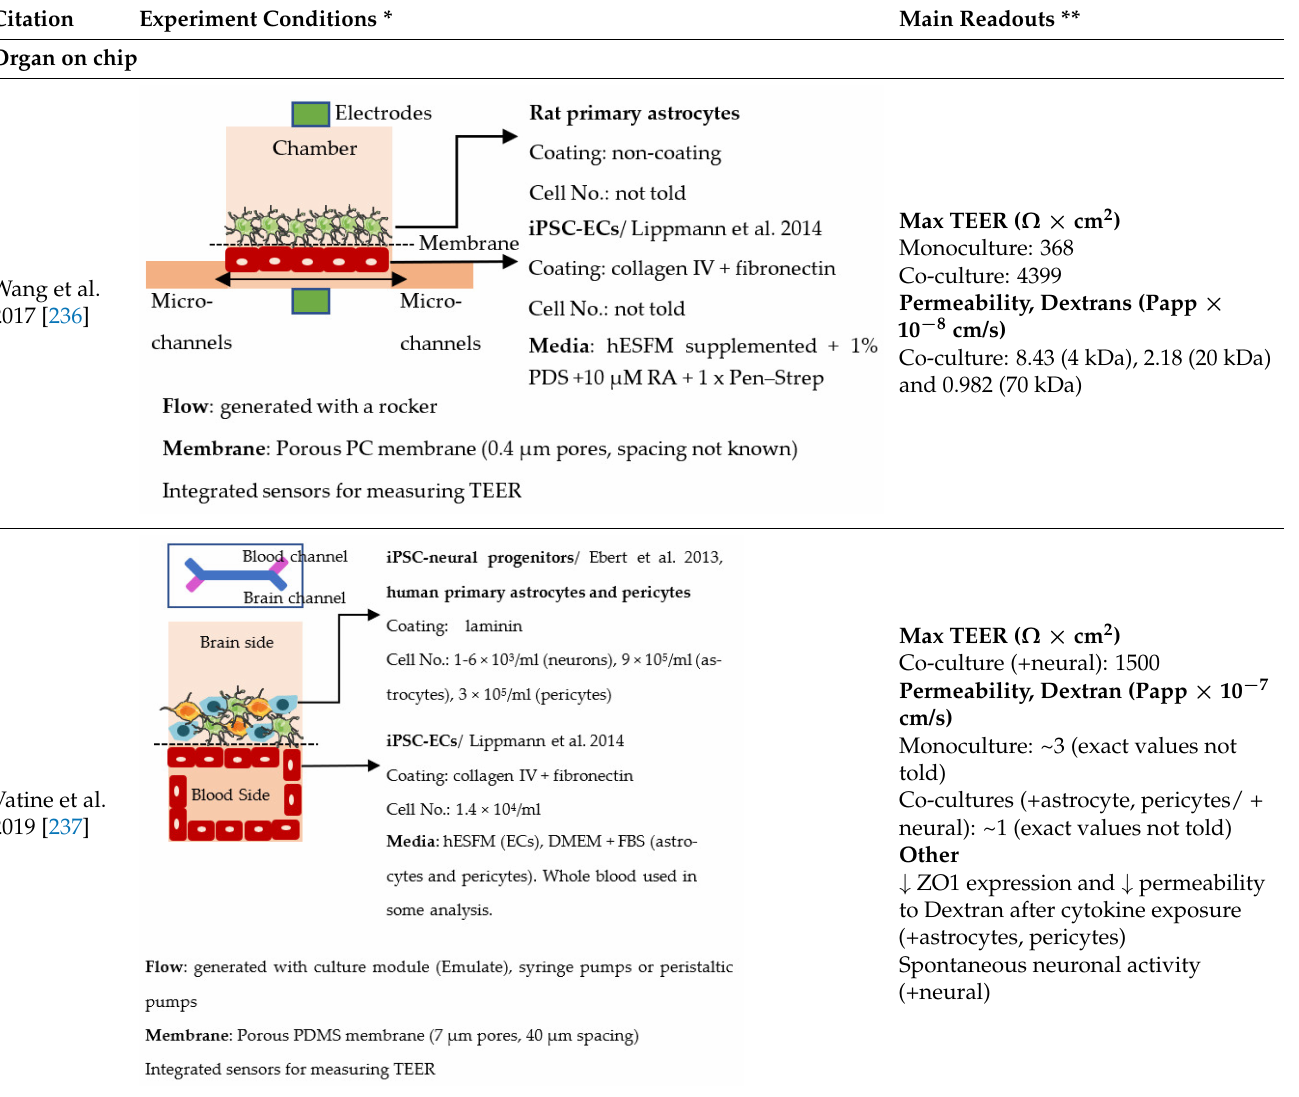
Table 2. Blood–brain barrier in vitro models (organ-on-chip, hydrogel model, and vascularized brain organoids).